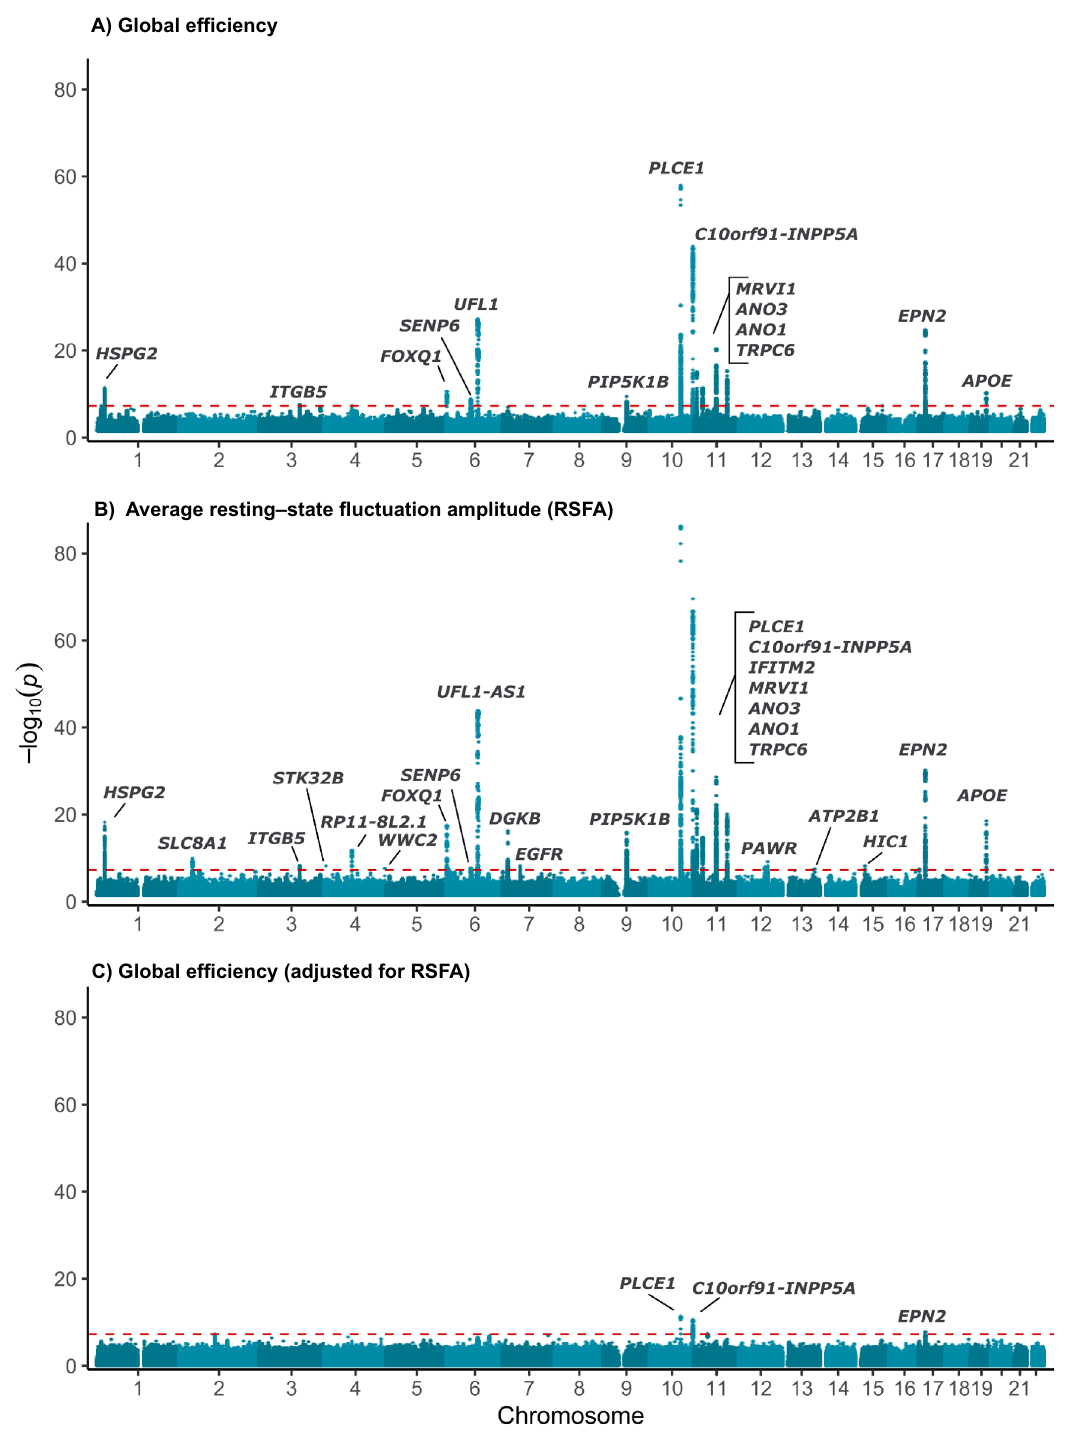
Figure 1. Manhattan plots for GWAS of a ( A ) global efficiency, ( B ) average resting state fluctuation amplitudes (RSFA), and ( C ) global network efficiency adjusted for RSFAPositional mapping used to assign loci to the nearest protein coding gene (see Materials and Methods for more